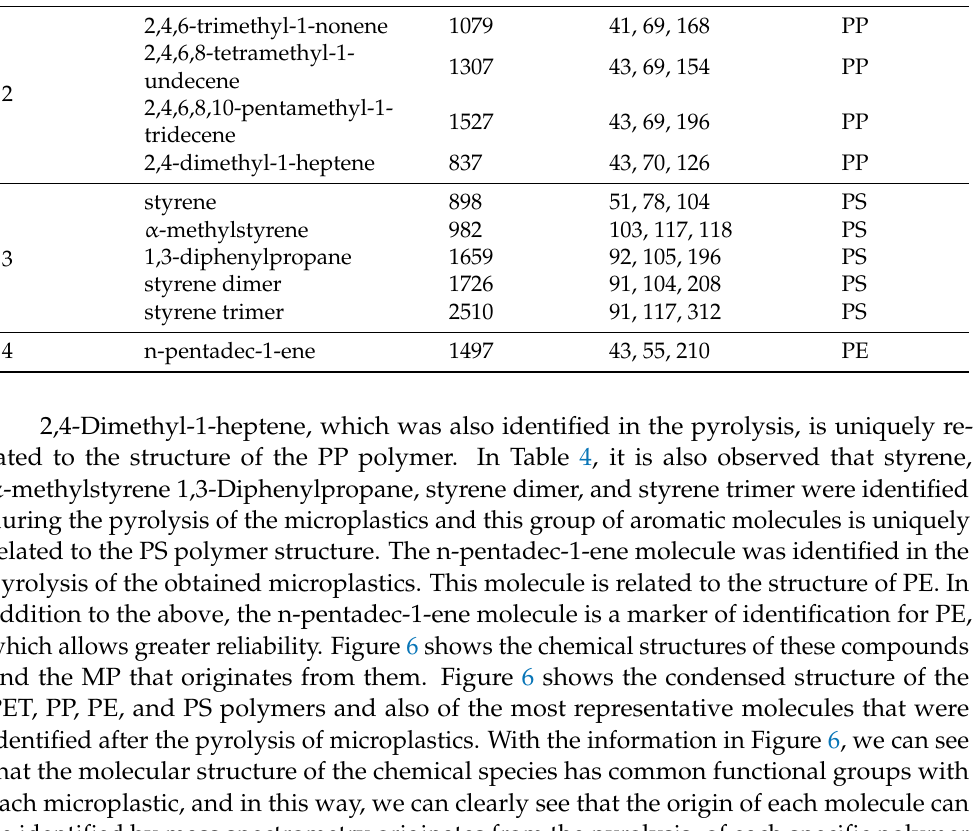
Table 4. Chemical compound data obtained by Py-GC-MS when analyzing polymer blends. Groups Identified Compounds RI